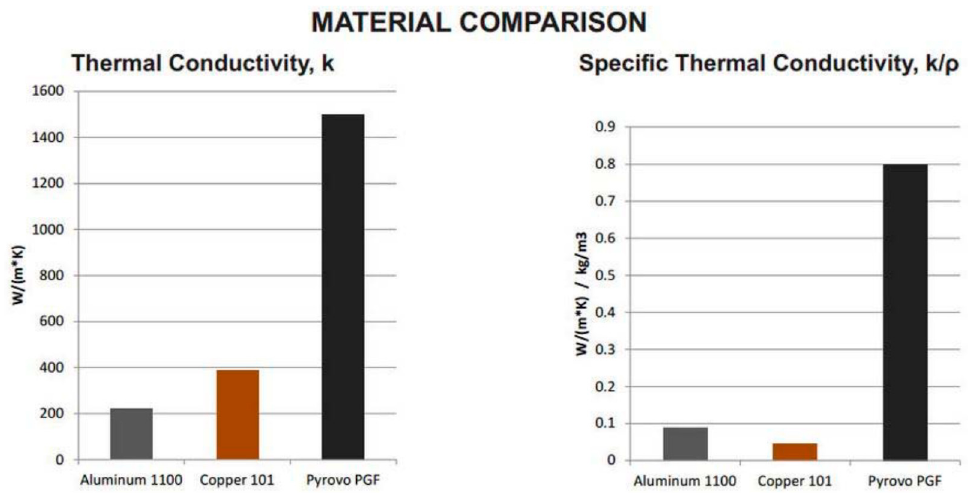
Figure 27. PGF vs. Aluminum and Copper Thermal Straps [45].